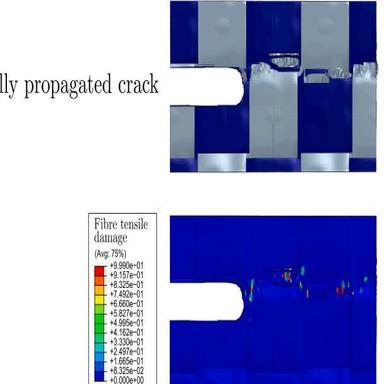
(Top) Stress in the loading direction, σ22, and fibre tensile damage in the tows, at 50% and 97% of the nominal strength, σNu, for the EC of the SENT virtual coupon. (Bottom) Post-peak crack band path, and tensile damage after propagation.